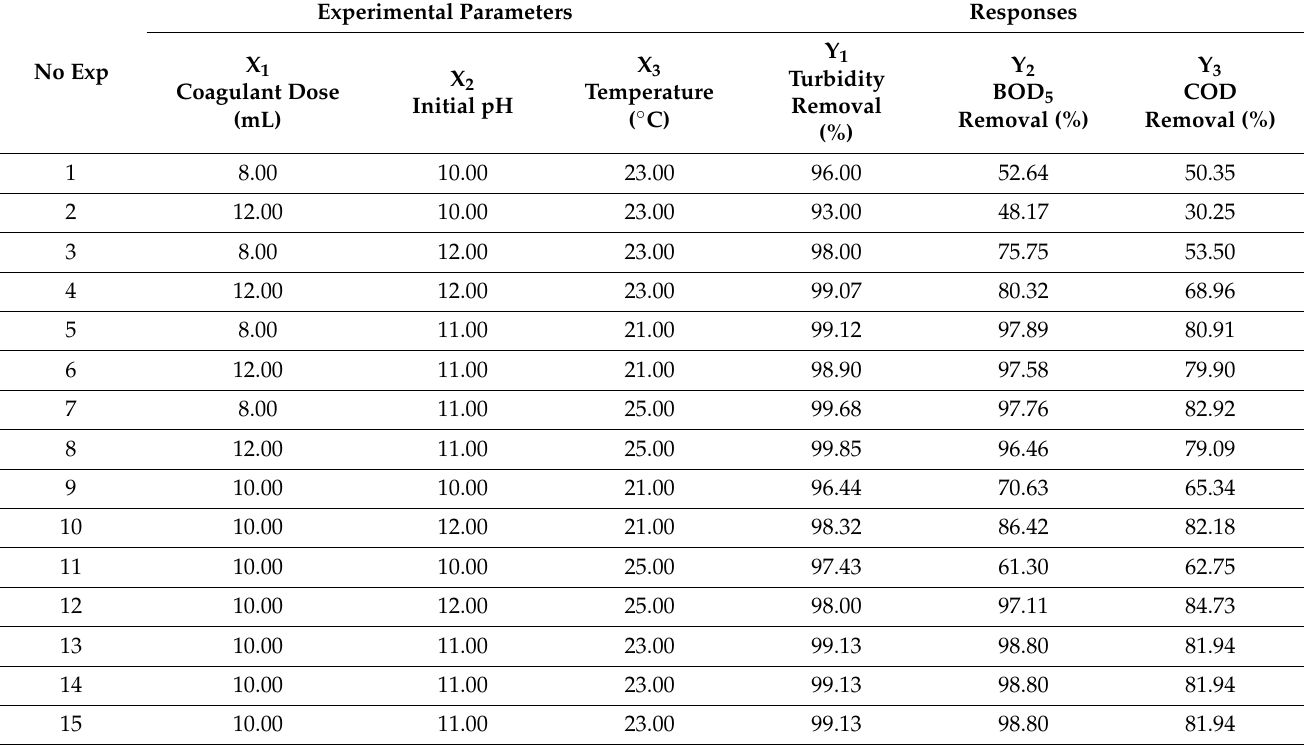
Table 1. Experimental design matrix for FW treatment using β -chitin extract.